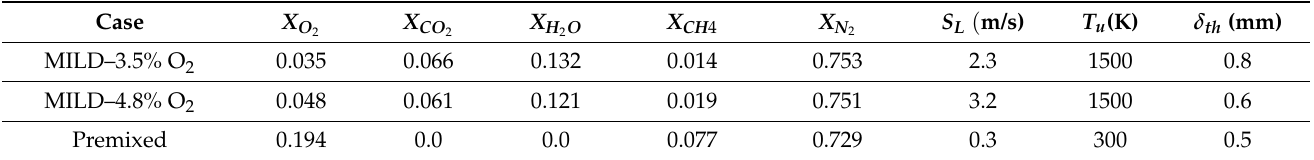
Table 1. Thermochemical conditions.